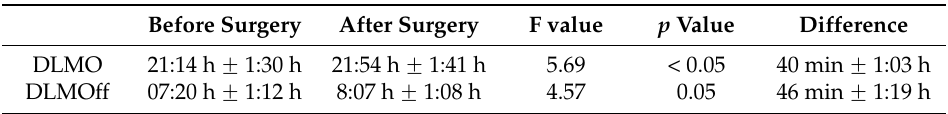
Figure 4. Correlation (Spearman) between chronotype (MSF) and the difference between the before and after cataract surgery measurements of dim light melatonin onset (DLMO). Table 2. Timing of dim light melatonin onset (DLMO) and offset (DLMOff) after subtracting seasonal confounding effects (see description in Section 3.2). Data are shown as average ± SD. N = 14 and 13 for DLMO and DLMOff, respectively.